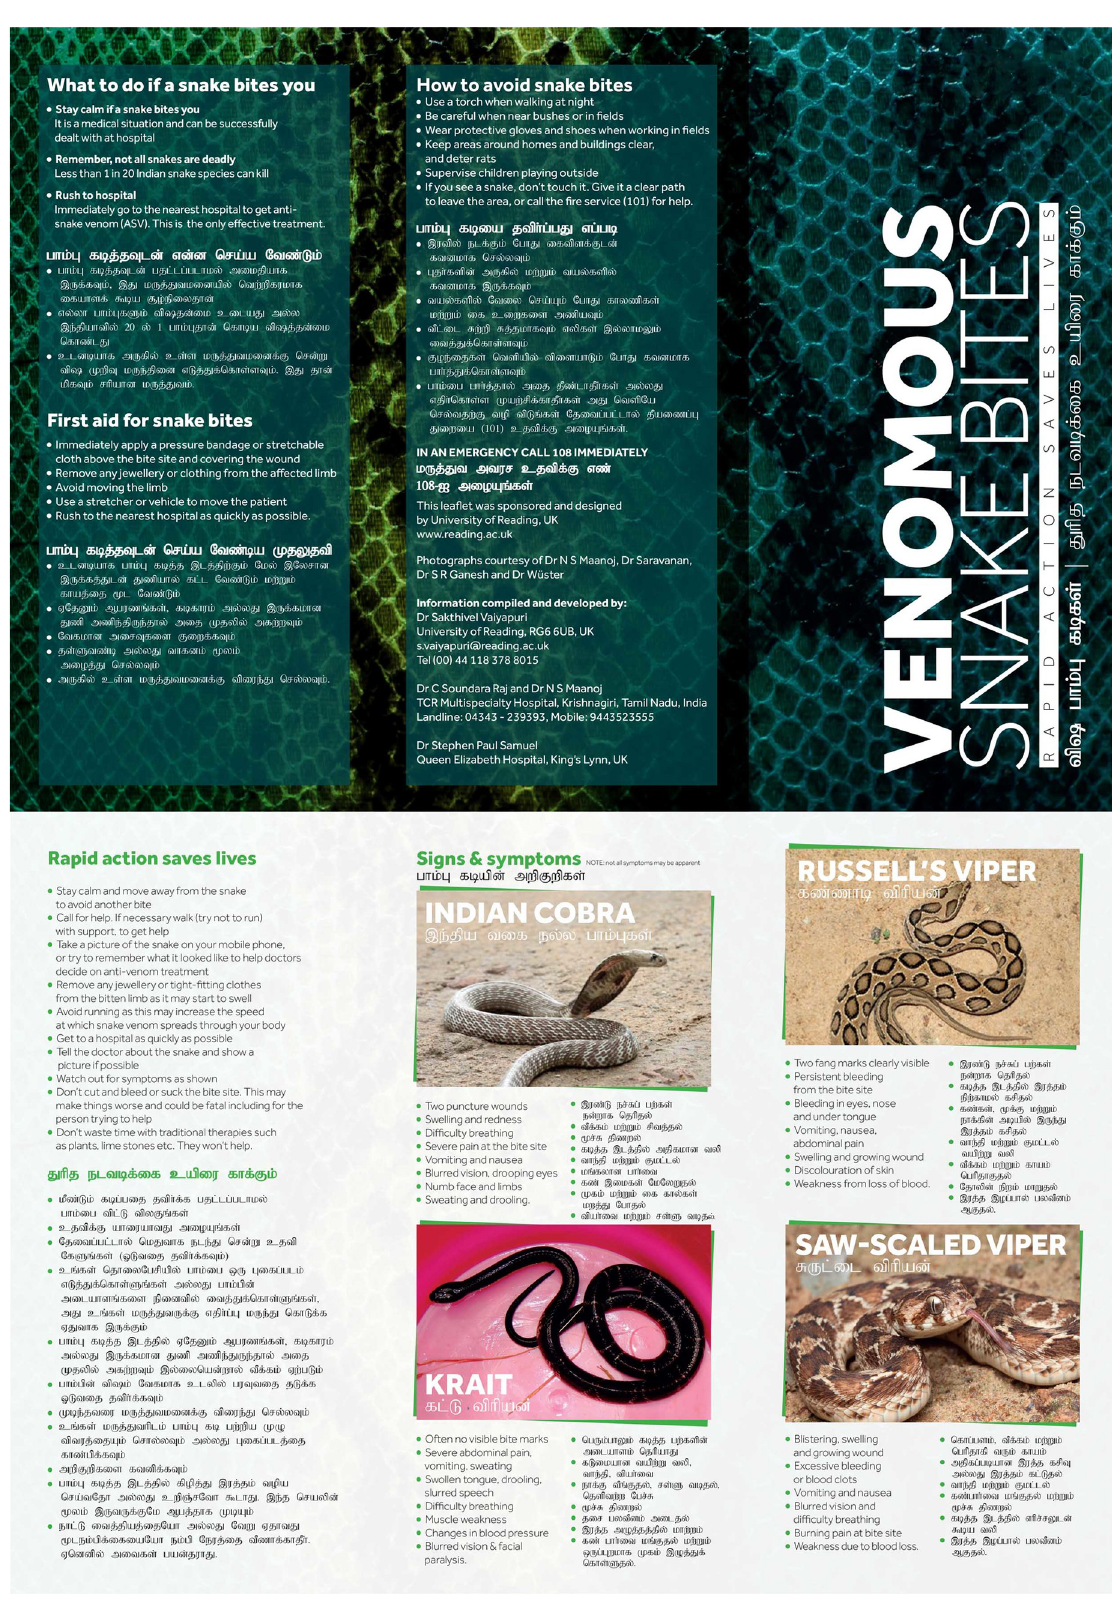
Fig 1. SBE information leaflet developed and used in this study. https://doi.org/10.1371/journal.pntd.0008911.g001 PLOS NeglectedTropical Diseases | https://doi.org/10.1371/journal.pntd.0008911 December31,